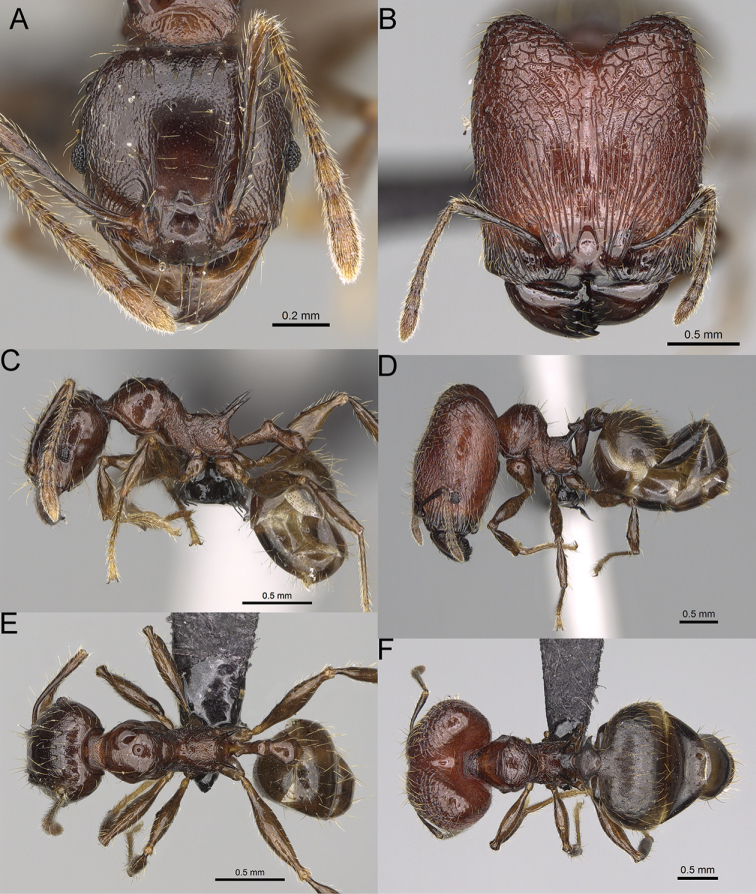
Pheidole
aelloea sp. nov., full-face view (A), profile (C), and dorsal view (E) of paratype minor worker (CASENT0923221) and full-face view (B), profile (D), and dorsal view (F) of holotype major worker (CASENT0236213).